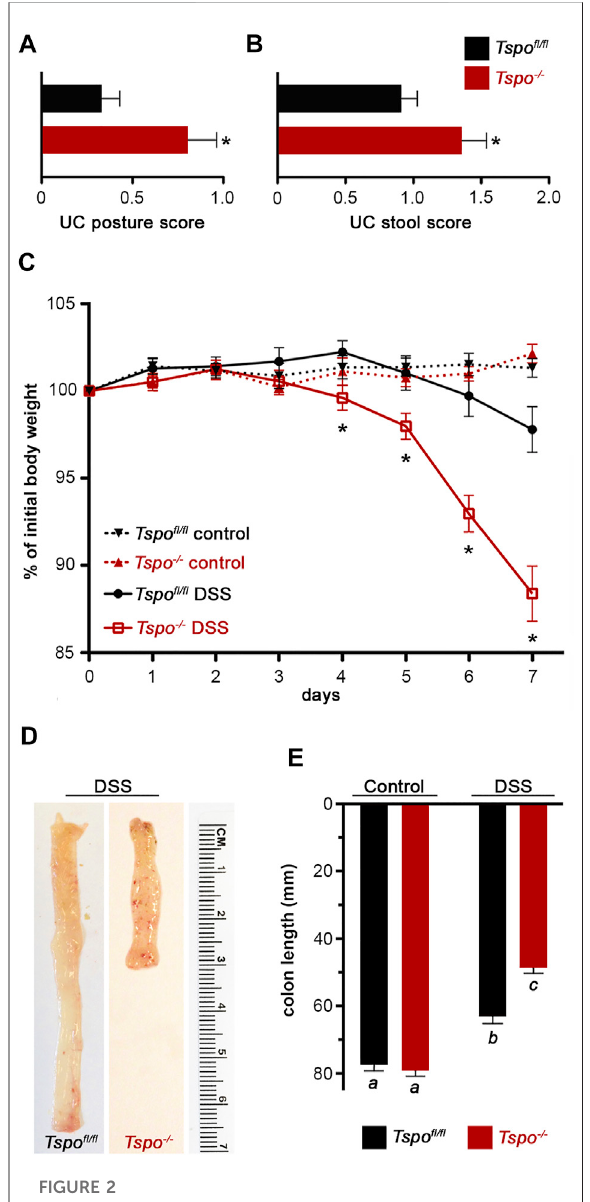
FIGURE 2 Exacerbated clinical signs and gross pathology of UC in Tspo − / − mice. (A) Severity of UC assessed by posturing scoring, days 5 – 7 of DSS in Tspo − / − and Tspo fl / fl mice ( n = 17 per group; p = 0.0053). Scoring: 0, normal behavior; 1, mild hunched posture; 2, hunched posture and reduced movement. (B) Severity of UC assessed by stool score, days 3 – 7 of DSS in Tspo − / − and Tspo fl / fl mice ( n = 17 per group; p = 0.03). Scoring: 0, normal stool; 1, soft feces, pink anus; 2, bloody feces, mild rectal bleeding; 3, moderate rectal bleeding; 4, diarrhea, severe rectal bleeding. (C) Body weight changes during UC in Tspo − / − mice indicated a signi fi cantly higher weight loss compared to Tspo fl / fl mice. Temporal changes over the 7-day DSS treatment graphed as percentage of initial body weight in Tspo − / − and Tspo fl / fl mice (n = 21 per group; ANOVA p = < 0.0001). Body weights at Day 4 ( p =